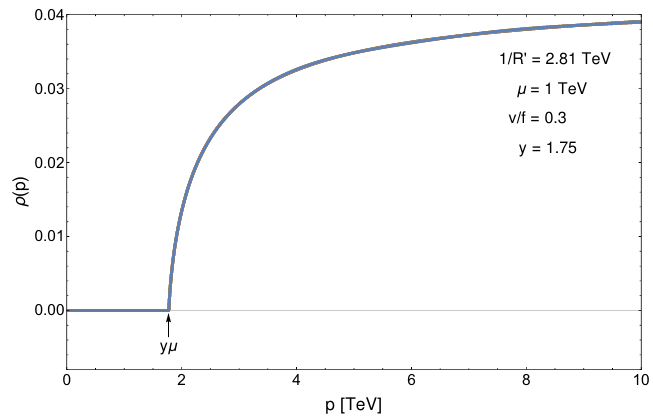
Figure 12 . Spectral densities for the remaining top partner quantum numbers. The (cid:12)gure contains ten overlapping spectral densities corresponding to components that are continuous across the IR brane.